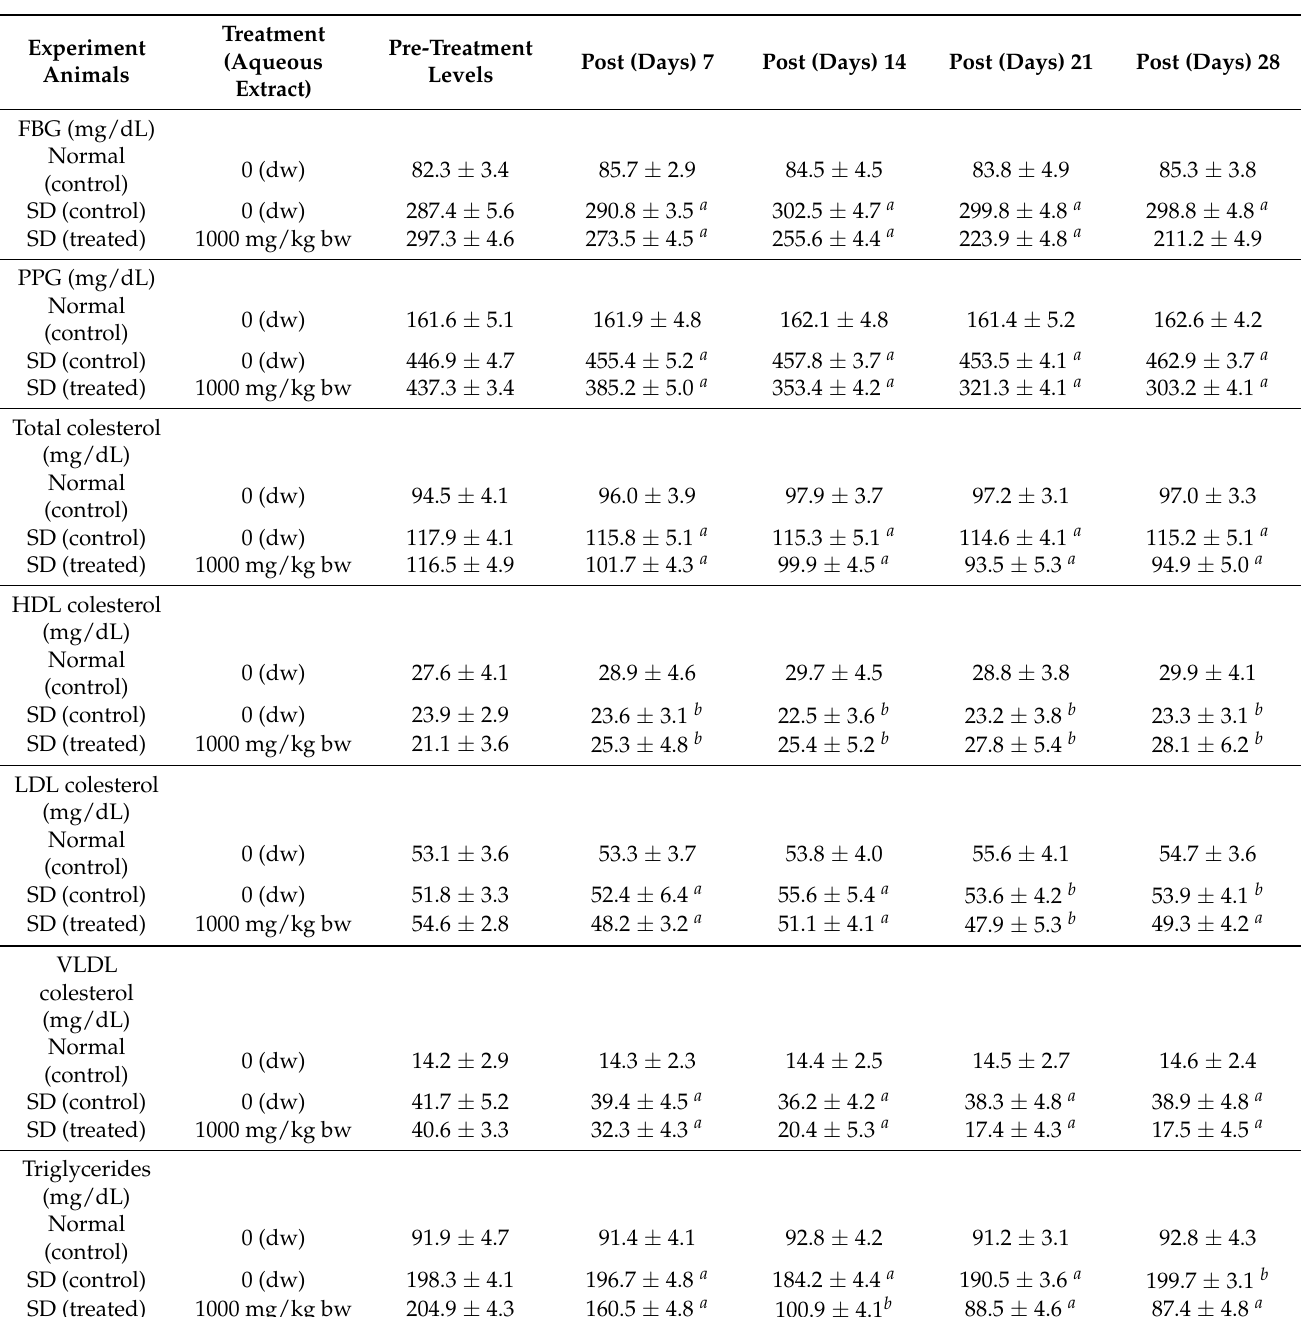
Table 5. Effect of graded dose of t. dioica leaves aqueous extract on blood glucose level and lipid profile of severely diabetic (SD) rats (mean ± s.d.) for pre- and post-treatment